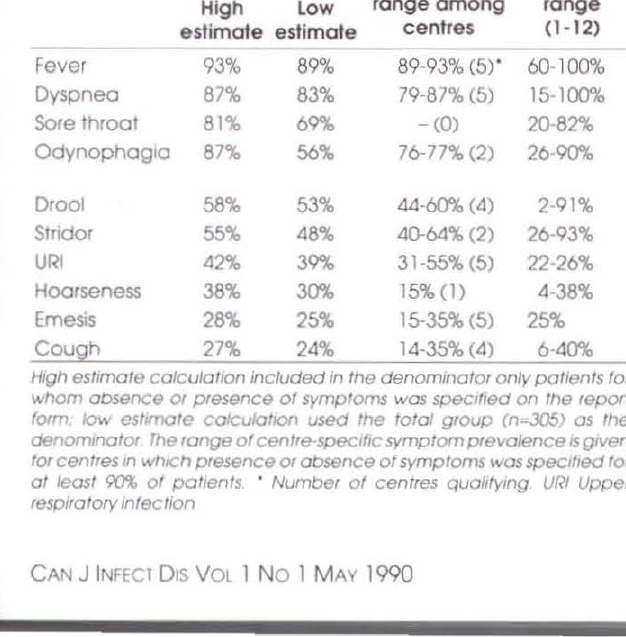
Prevalence of presenting symptoms in Canadian children with epigloHitis Total group Low Previously